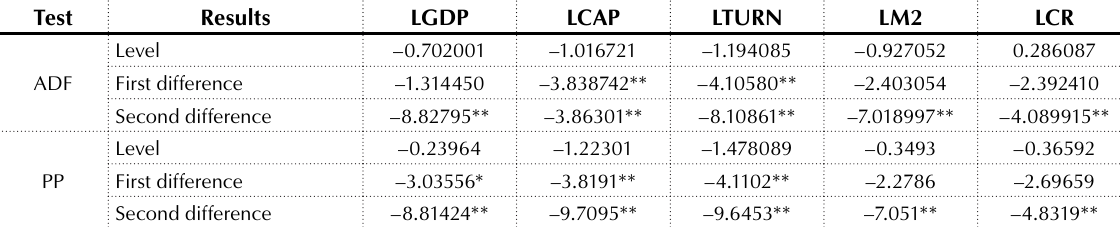
Table 1. Unit root tests